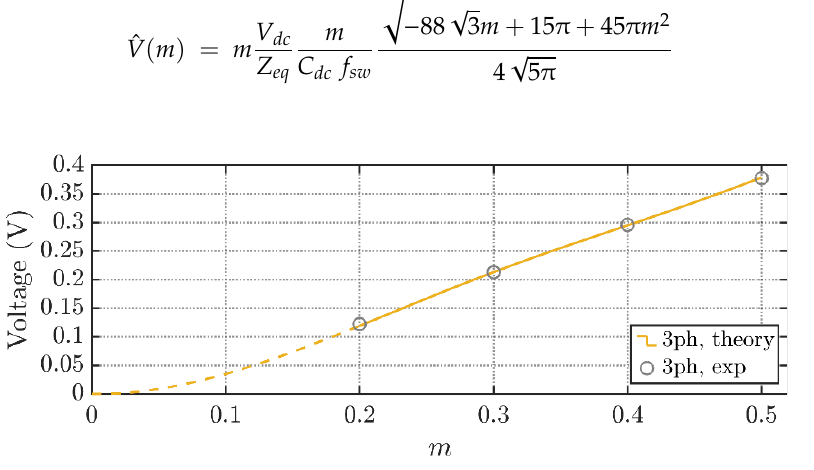
Figure 17. Dc link voltage switching ripple rms for high values of modulation index.